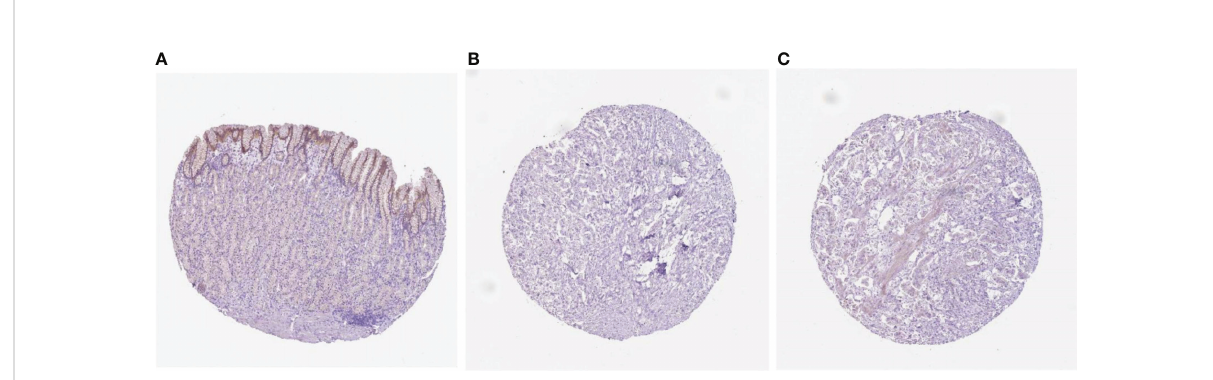
FIGURE 13 Comparison of TMEM236 expression at the protein level immunohistochemistry pictures. (A) normal (left) and (B, C) tumor (middle and right)